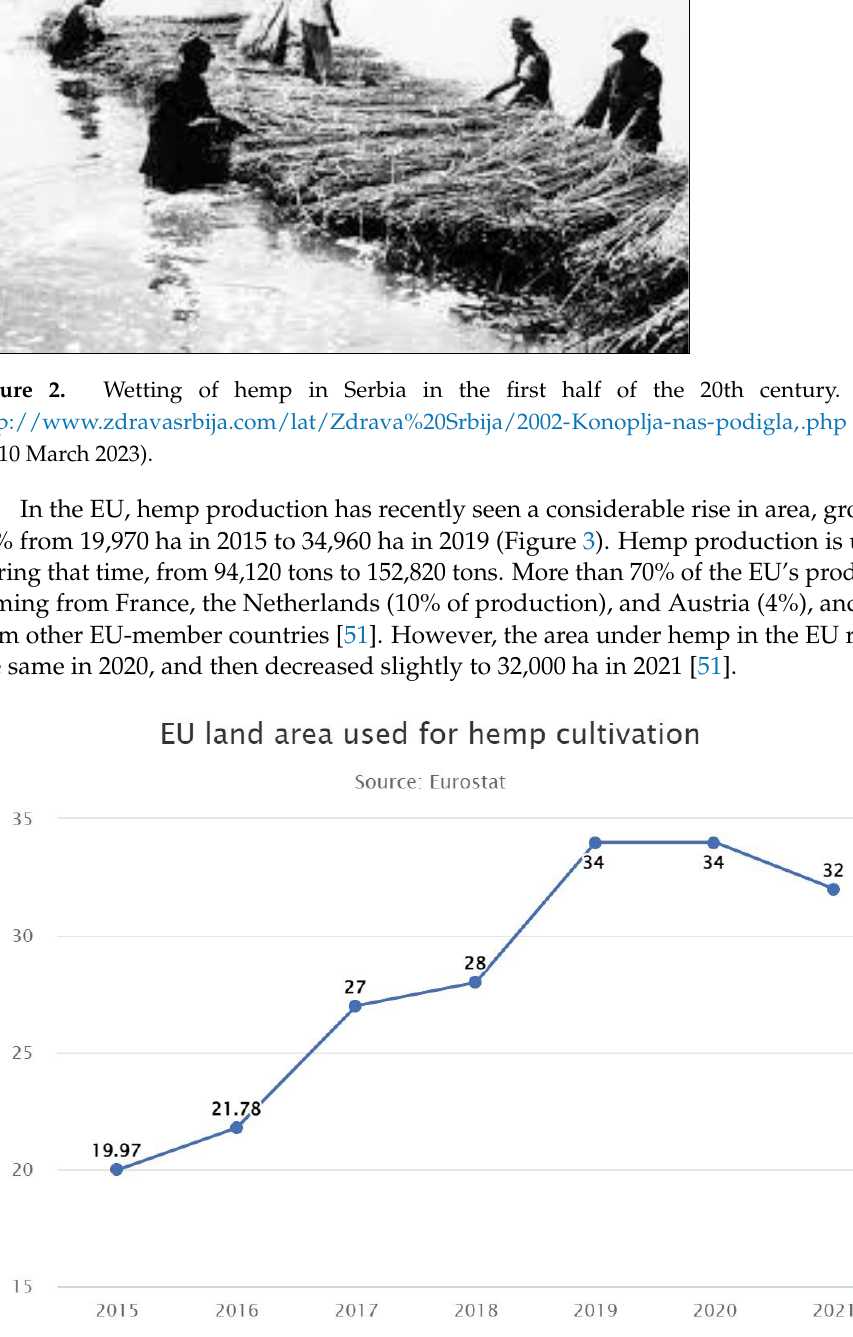
Figure 3. EU Land area used for hemp cultivation (Source: EUROSTAT https://agriculture.ec.europa.eu/farming/crop-productions-and-plant-based-products/hemp_en (accessed on 10 March 2023).